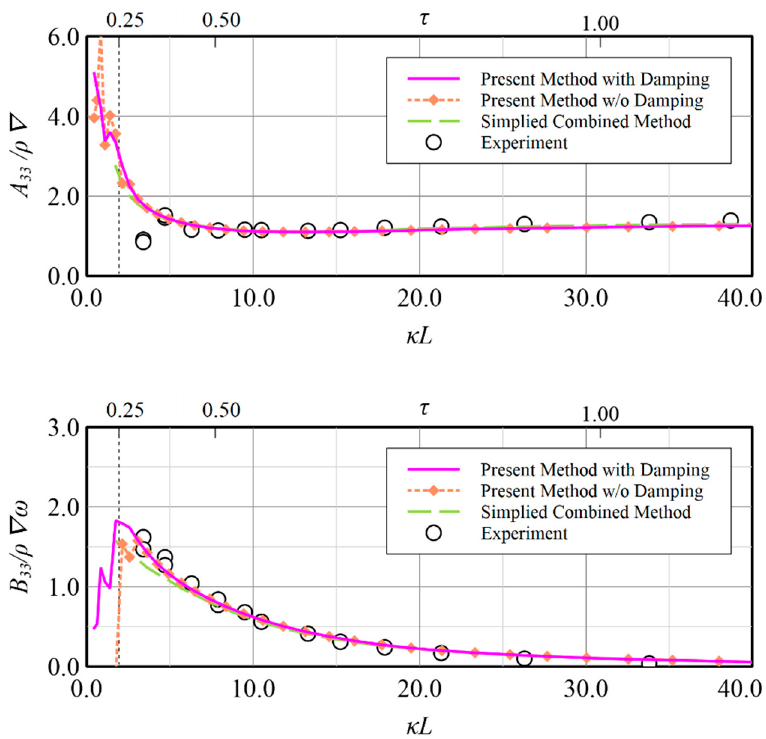
Figure 15. Heave-induced-heave added mass and damping coefficient at F r = 0.18.